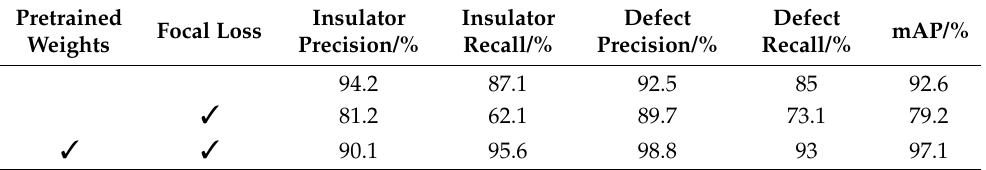
Table 4. Comparison of transfer learning results.